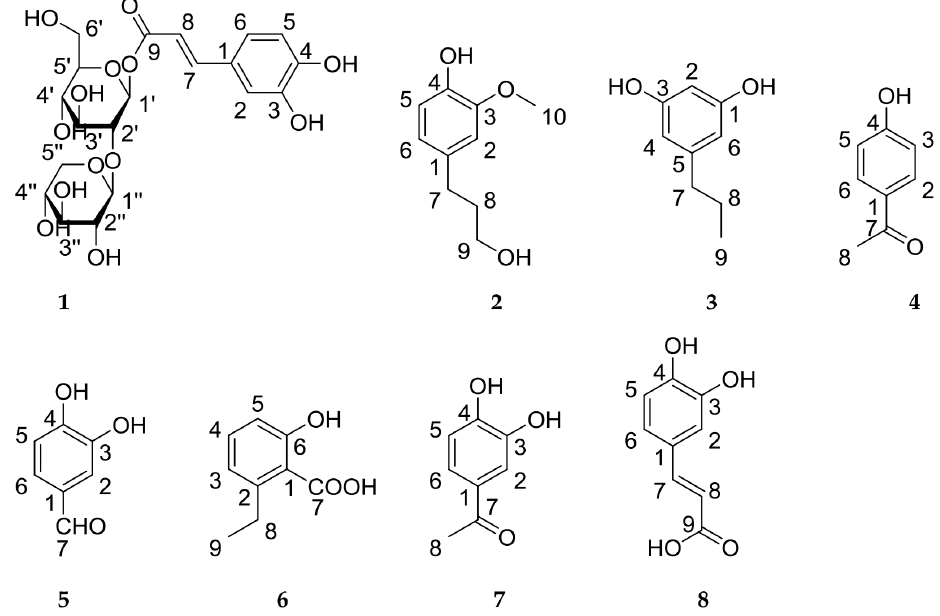
Figure 2. Structures of 1 – 8 isolated from D. fragrans .